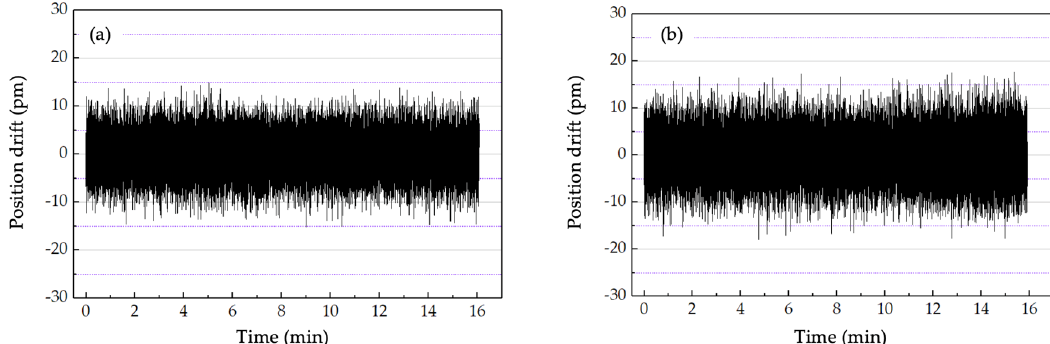
Figure 7. Position drift when the offset-locked frequency was set to ( a ) 10 and (b) 20 MHz.